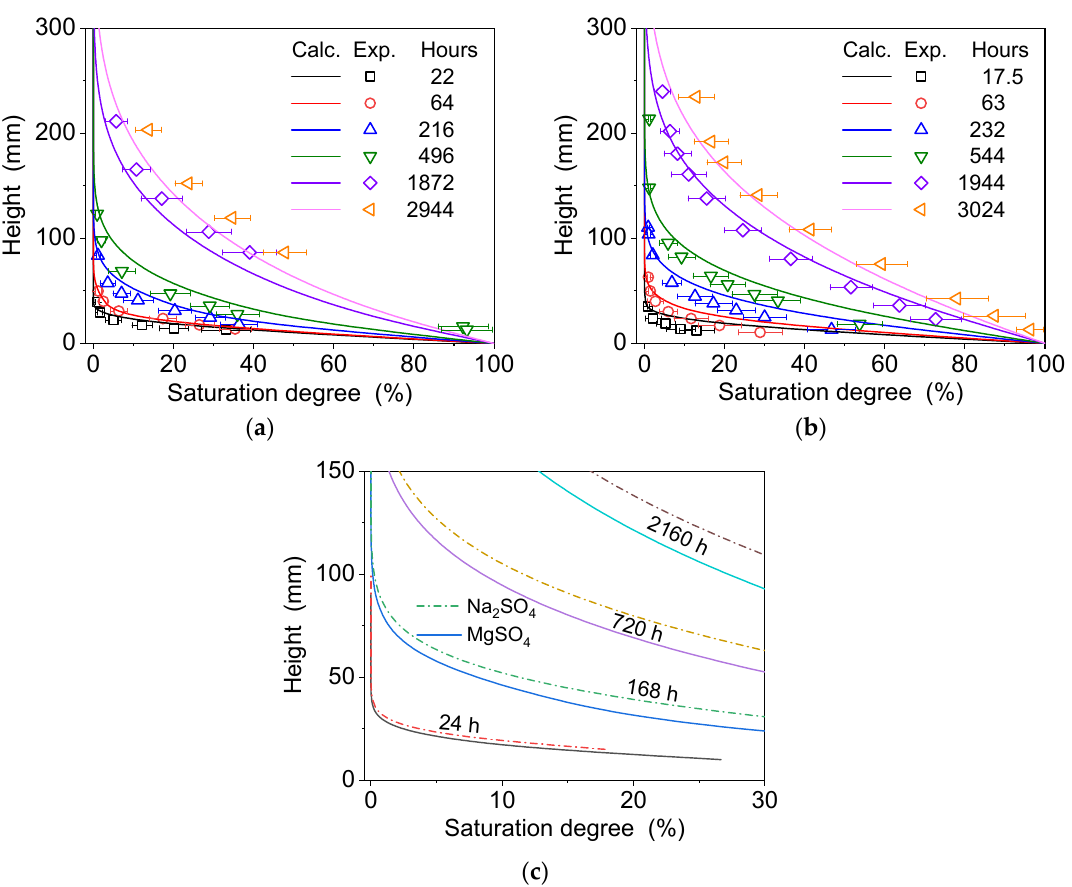
Figure 3. Profiles of saturation degree over time (in the dissolution and diffusion processes of single electrolyte in water): ( a ) MgSO 4 ; ( b ) Na 2 SO 4 ; ( c ) calculated results of MgSO 4 and Na 2 SO 4 .